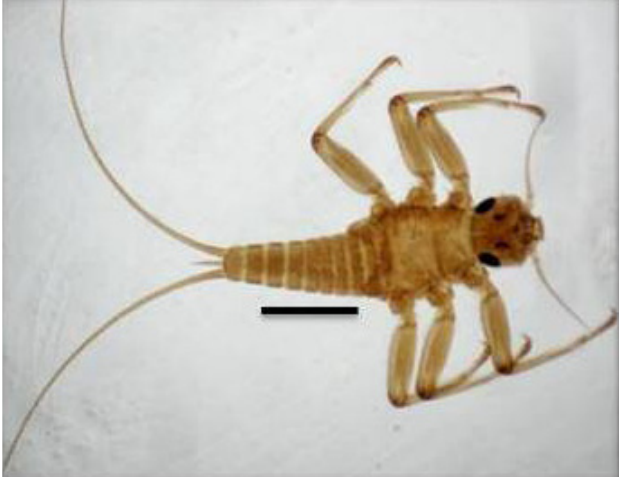
Figure 1. B. huaico nymph, dorsal view. Scale bar